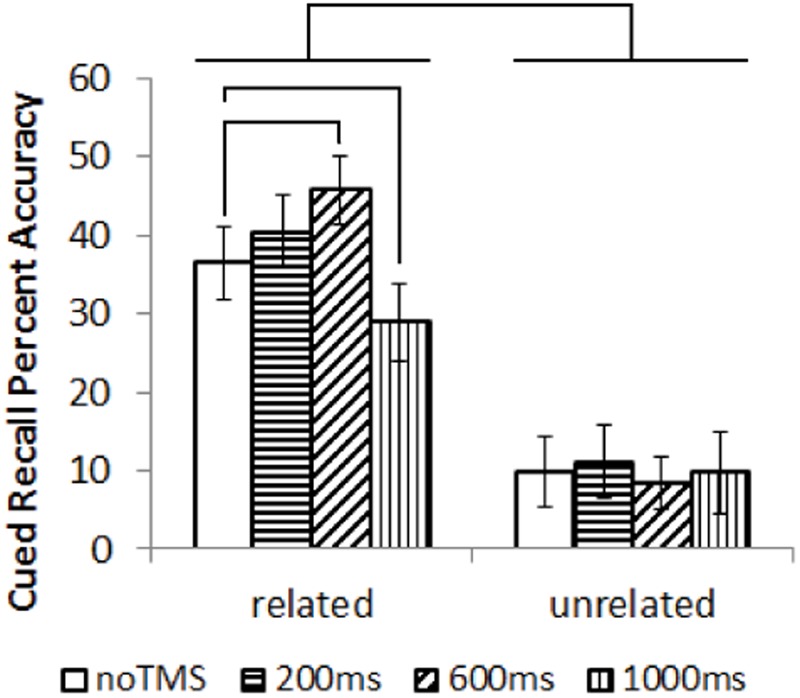
Results (mean with error bars representing standard deviation) of the cued recall test, performed outside the MRI. Lines represent significant differences between conditions (Wilcox Ranked Signs test, p < 0.05).